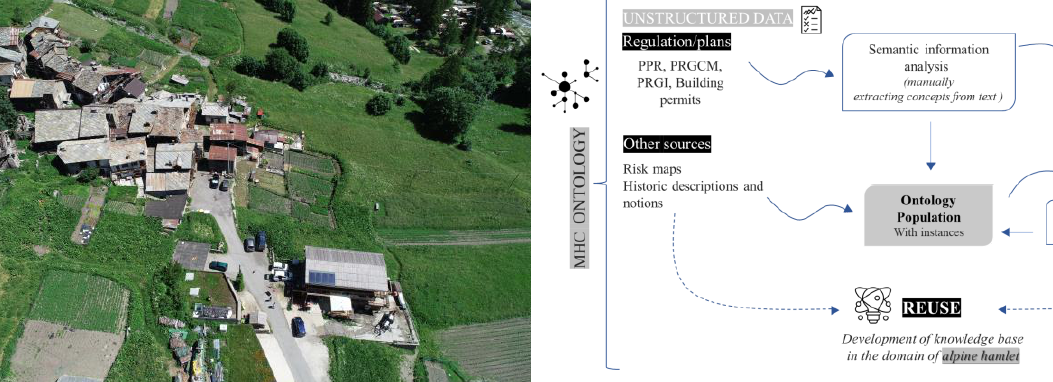
Figure 2. Aerial view of Pomieri hamlet case study.